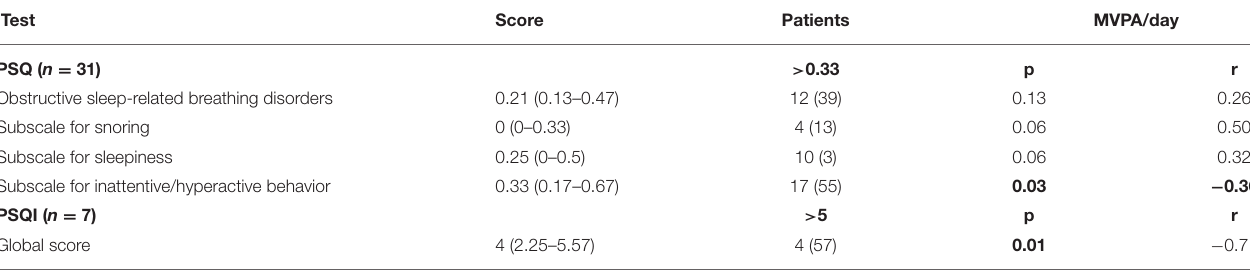
TABLE 4 | Results of the PSQ and PSQI